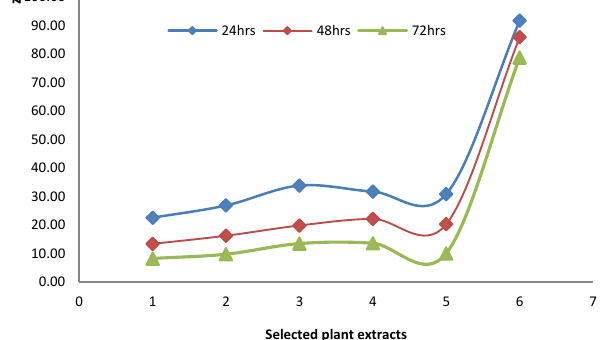
Figure 1: Effect of different plant extracts on the survival (%) of mean no. of yellow mite population